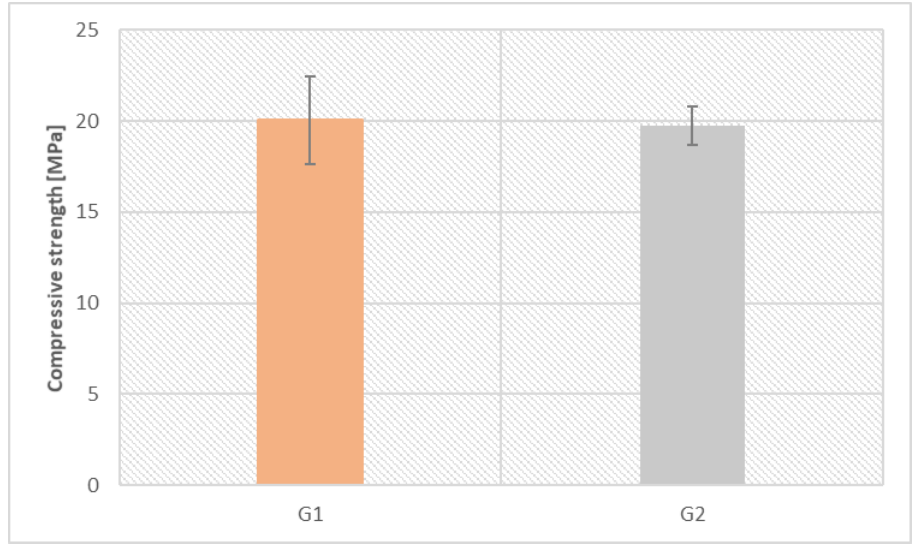
Figure 3. Compressive strength (MPa) of the samples after 28 days of curing.